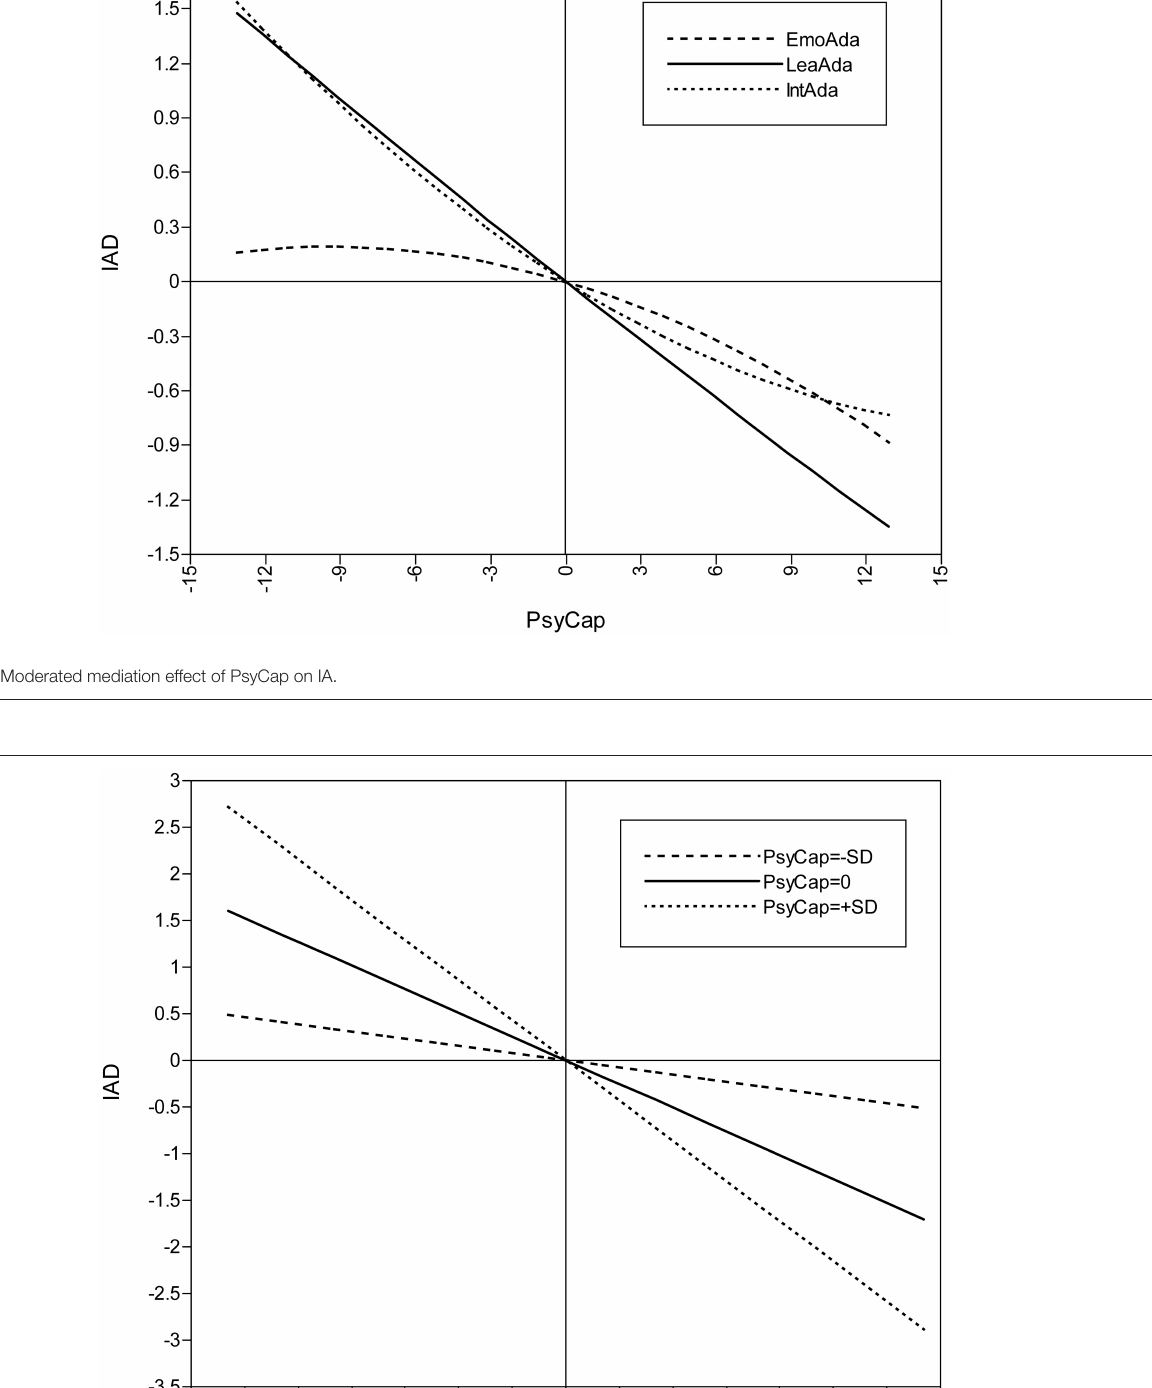
Frontiers in Psychiatry |